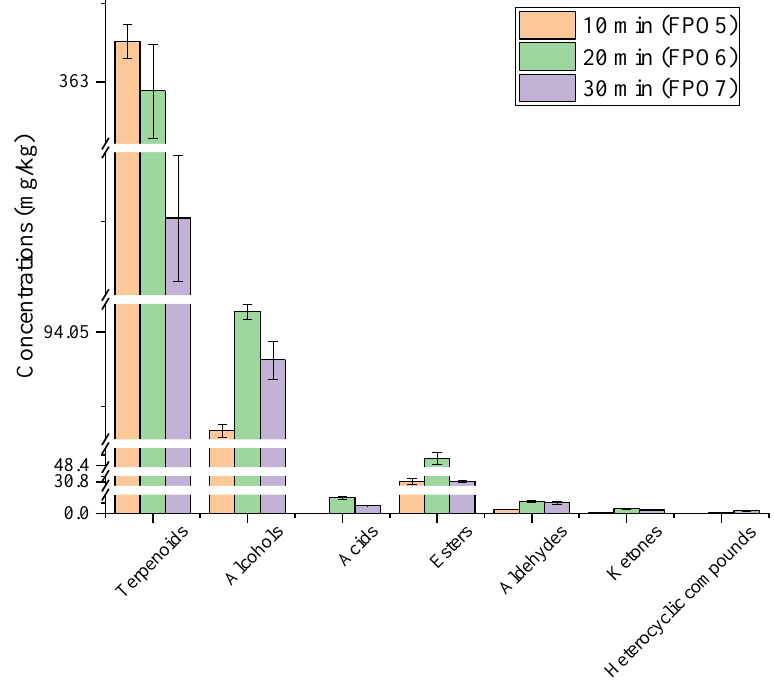
Figure 5. Volatile compound concentrations of FPOs with different frying times.